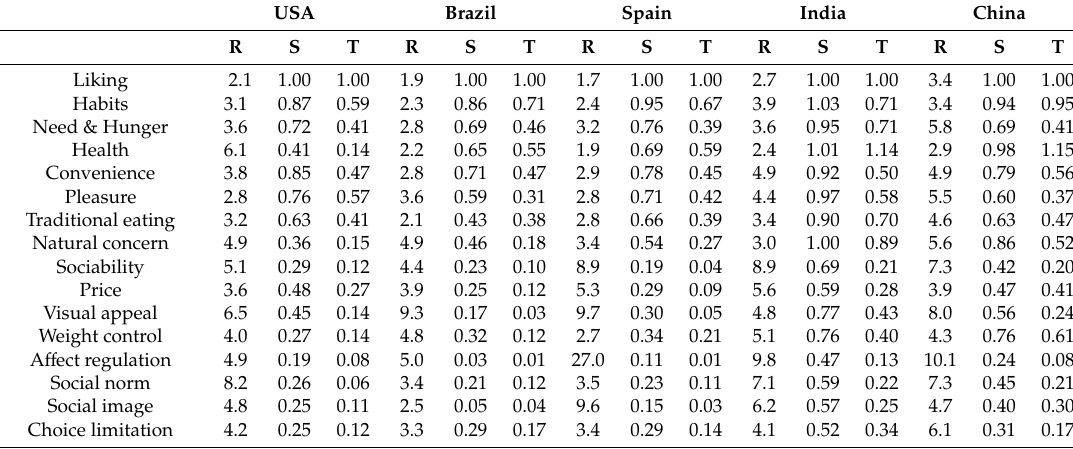
Table 5. Ratios of CAS “agree” responses to CATA “agree” responses and standard indices of importance for CAS and CATA “agree” responses for each motivation construct to the liking construct for dairy foods in all five